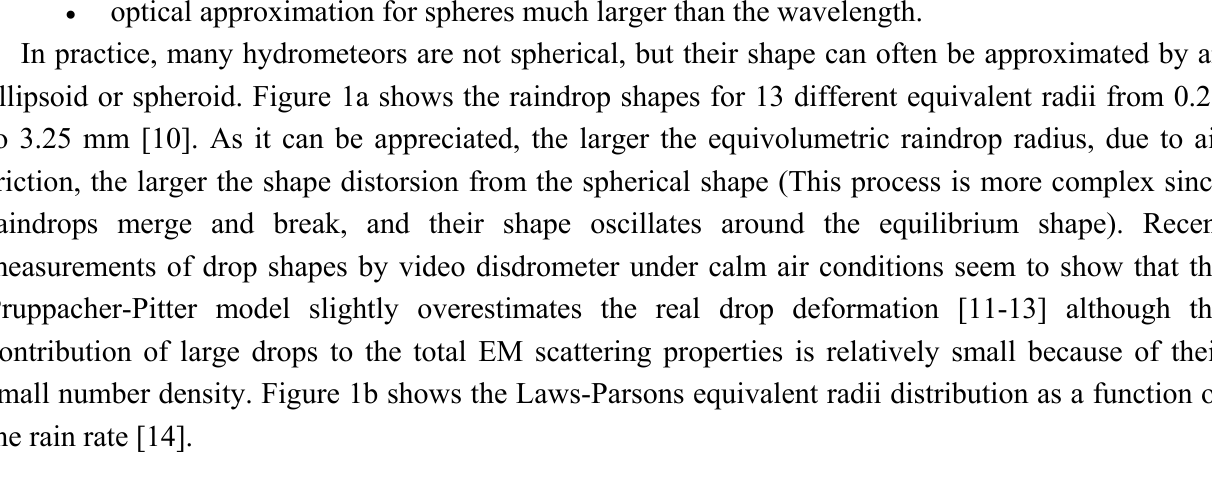
Figure 1a. Shape of a raindrop for equivalent radii: 0.25, 0.50 ... 3.25 mm.